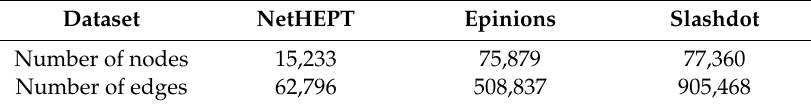
Table 1. Three social network datasets used in the simulation.